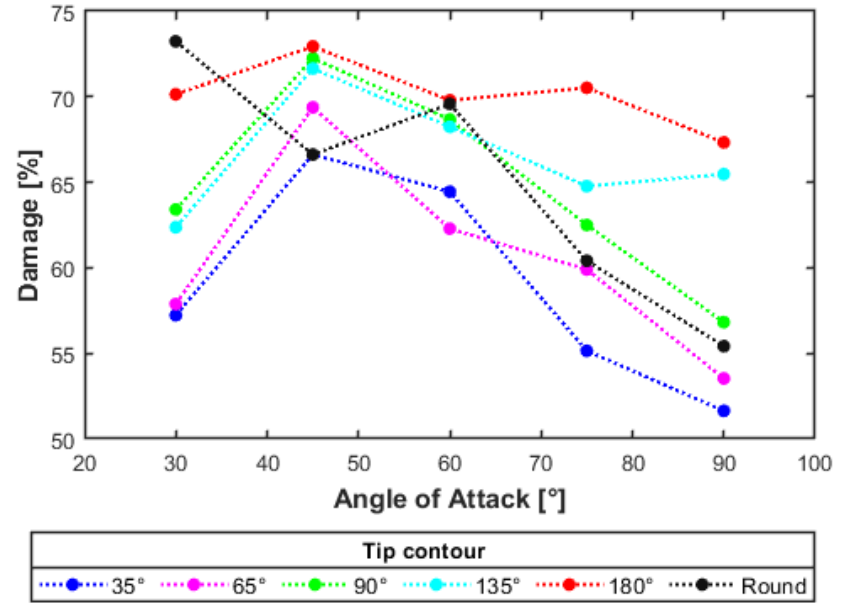
Figure 6. Damage vs. AoA.